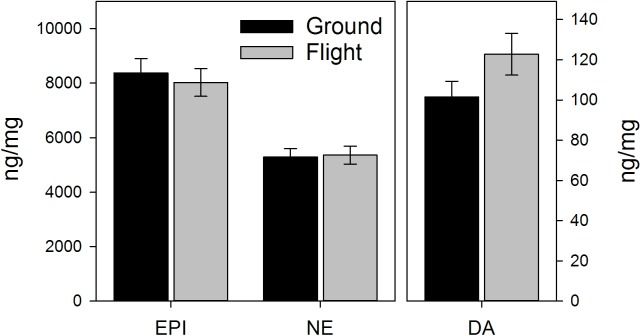
Effects of spaceflight on catecholamine levels in the adrenal gland.Catecholamines measured via HPLC. EPI = epinephrine. NE = Norepinephrine. DA = dopamine. Values represent means ± SEM. N = 13 for Ground controls, 7 for Flight.